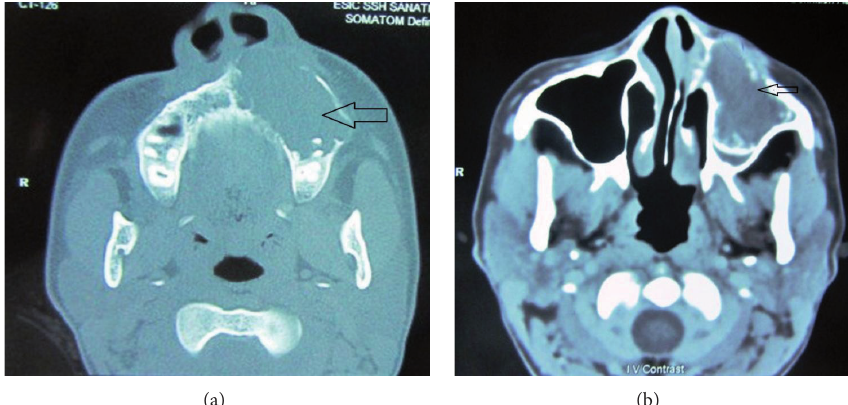
Figure 4: Axial CT Scan sections showing the lesion perforating the anterior wall of the antrum and its extension in to the nasal cavity.